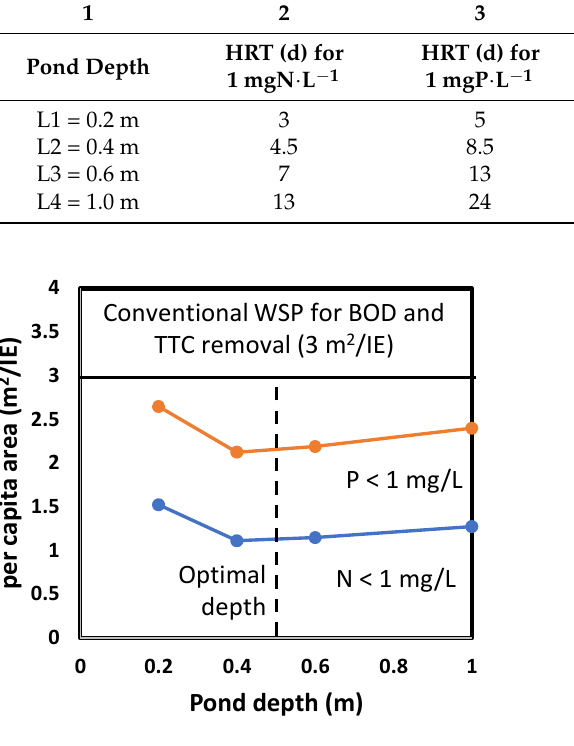
Figure 8. Per capita area for nutrient removal in SBPP to produce effluent with less than 1 mgN · L − 1 and 1 mgP · L − 1 as a function of the pond depth.